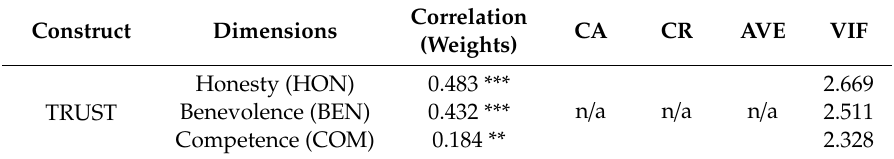
Table 4. Second-order measurement model of the formative